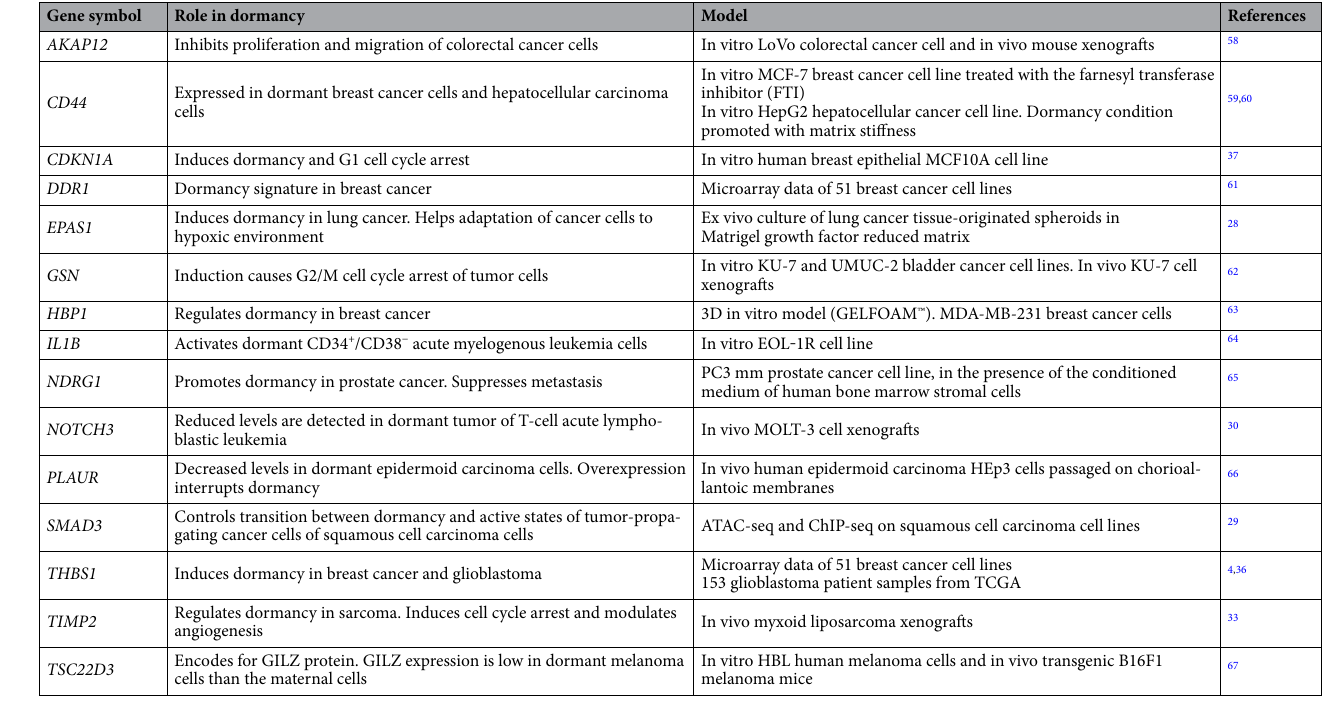
Table 2. The genes in the dormancy–interaction network and the mechanisms associated with